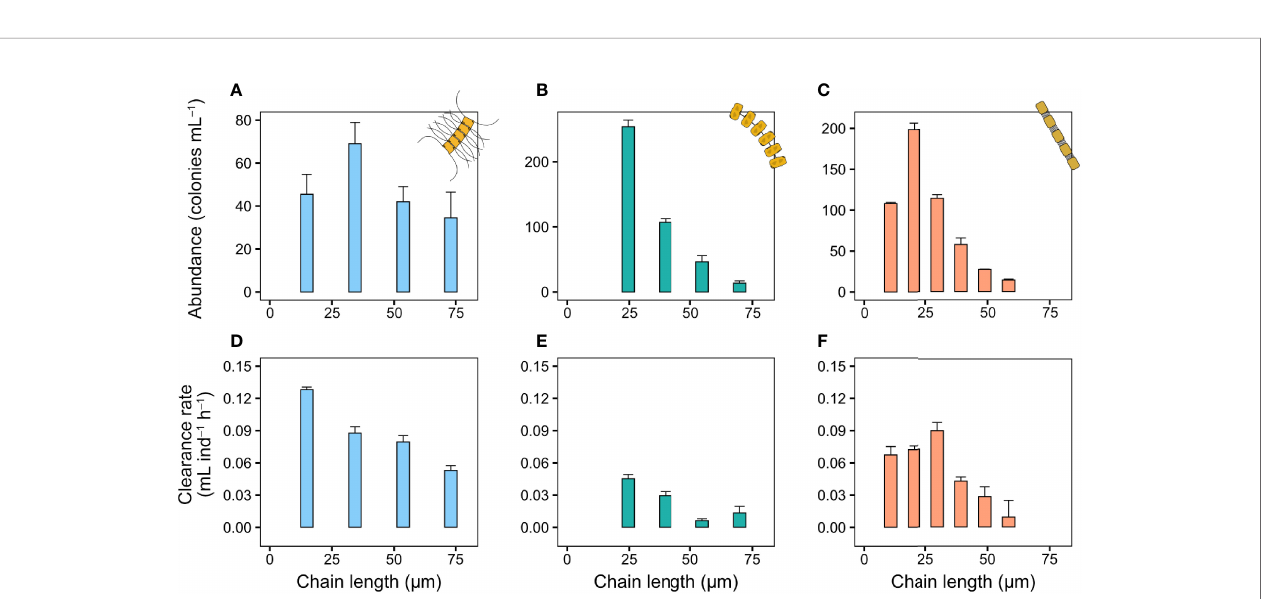
FIGURE 4 | Copepod nauplii clearance rate (mL nauplii − 1 h − 1 ) and colony size distribution of chains in the bottle incubations. (A, D) C. af fi nis , (B, E) T. nordenskioeldii , and (C, F) S. marinoi. Sizes larger than the largest chains shown here (equivalent to four cells chain − 1 in C. af fi nis and T. nordenskioeldii , and six in S. marinoi ) were pooled into one group due to low abundance of these sizes. Values are means and error bars show standard error (n =